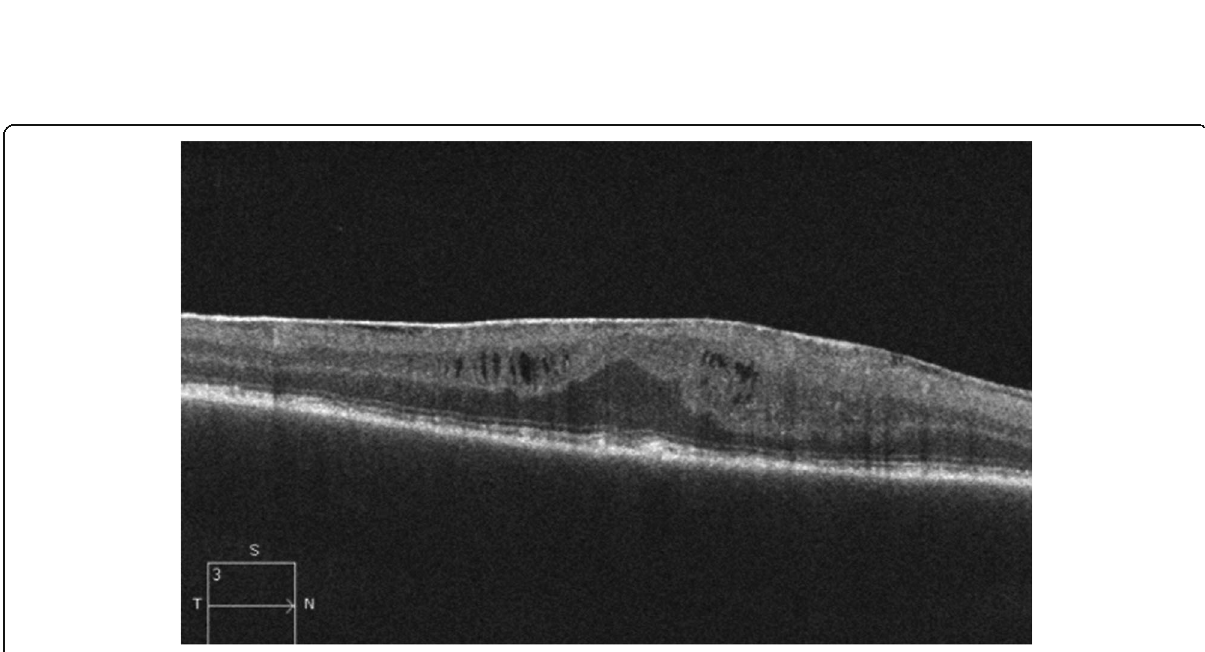
Fig. 4 OCT right eye, 1 year after the initiation of treatment for panuveitis from SO. ERM without significant inner retinal wrinkling, loss of foveal contour, mild intraretinal edema, and significant RPE